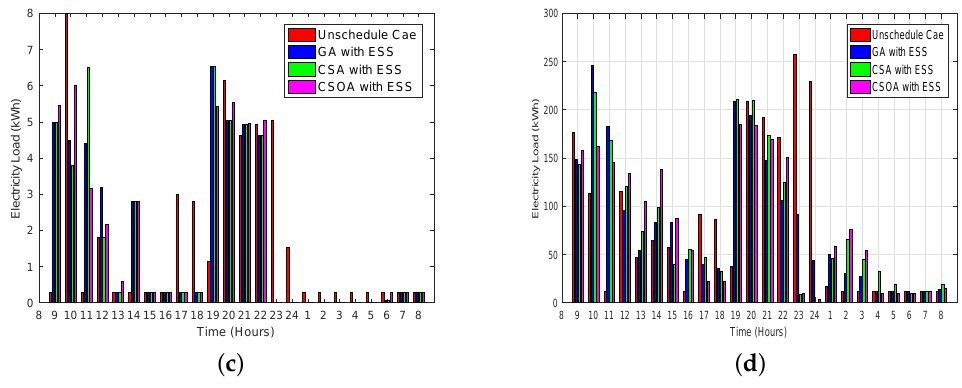
Figure 8. Hourly electricity consumption for single and multiple homes. ( a ) Hourly electricity load for a single smart home without ESS; ( b ) hourly electricity load for 30 smart homes without ESS; ( c ) hourly electricity load with ESS for a single smart home; ( d ) hourly electricity load with ESS for 30 smart homes.